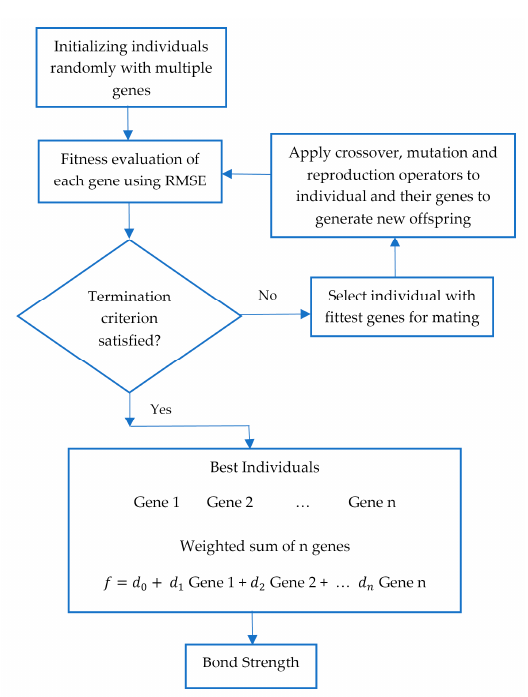
Figure 2. The MGGP block diagram.